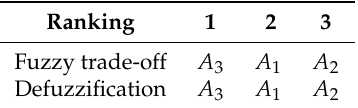
Table 8. Ranking by fuzzy